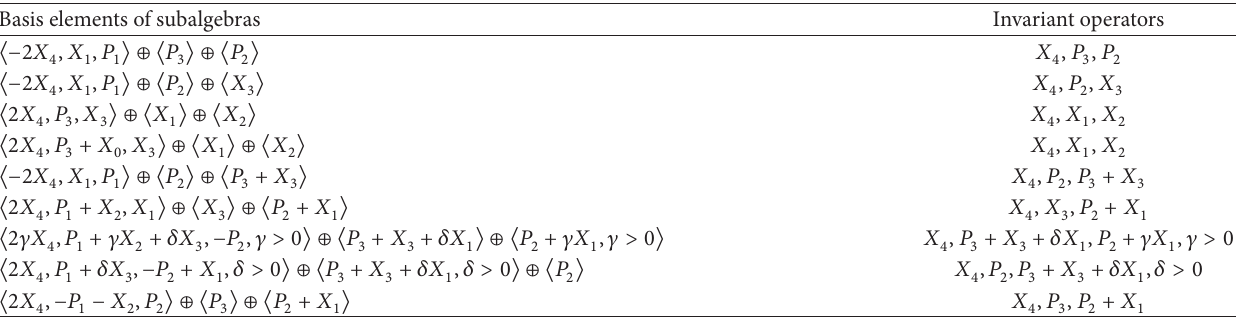
Table 1: Invariant operators of subalgebras of the type 𝐴 3,1 ⊕ 𝐴 1 ⊕ 𝐴 1 . Basis elements of subalgebras Invariant